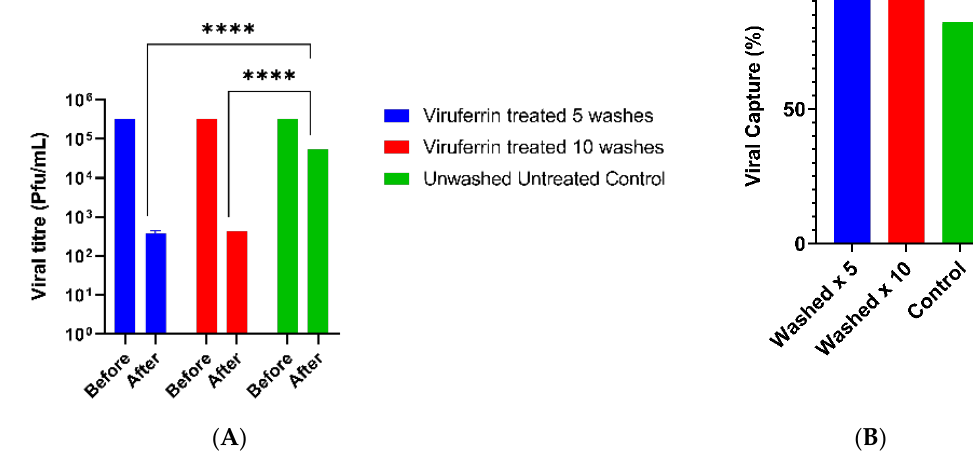
Figure 3. The stability of the Viruferrin treated fabric material was assessed by washing the treated fabric material either 5 or 10 times. Each assay was conducted in triplicate with an unwashed non-treated fabric as control. Each individual inoculated well containing SARS-CoV-2 was wiped, with a single action, per piece of fabric. The viral titer of each well was determined using the microneutralization CPE-based assay. ( A ) The bars represent GMTs, and the standard deviations are shown with error bars. Data was analyzed for significance using a 2-way ANOVA with Sidak’s multiple comparisons test (alpha = 0.05, p **** ≤ 0.0001) comparing Viruferrin-treated and the control fabric samples. ( B ) The Capture Rate of SARS-CoV-2 is expressed as a percentage based upon the viral titer of the starting inoculum. Each bar represents the test in